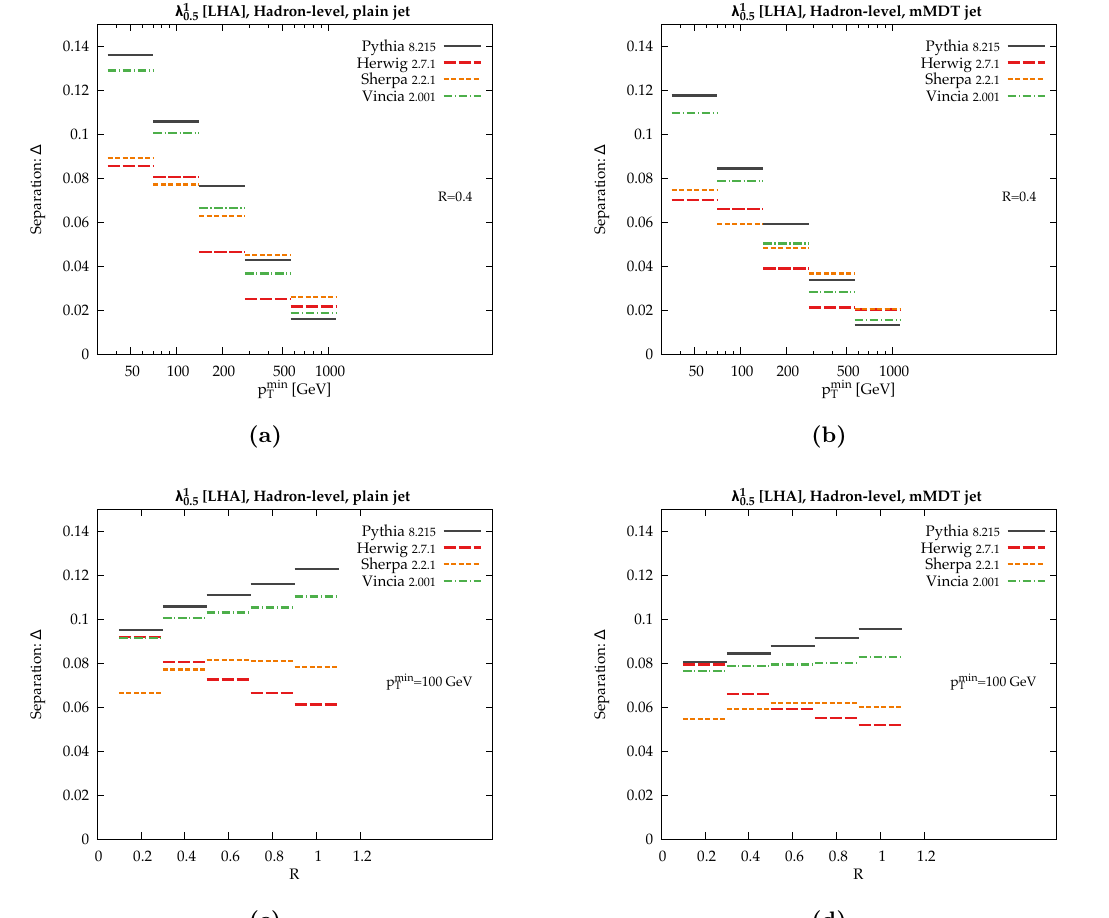
Figure 20. Classi(cid:12)er separation (cid:1) for the LHA in our LHC study, sweeping p min radius R (bottom row). Results are shown with all jet constituents (left column) and after mMDT grooming (right